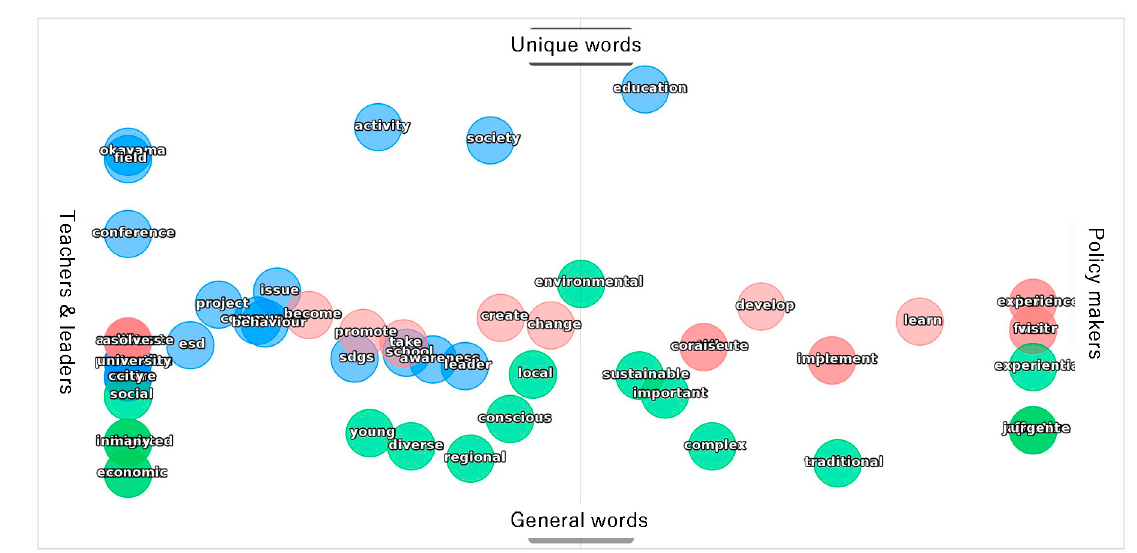
Figure 10. Feature word map.